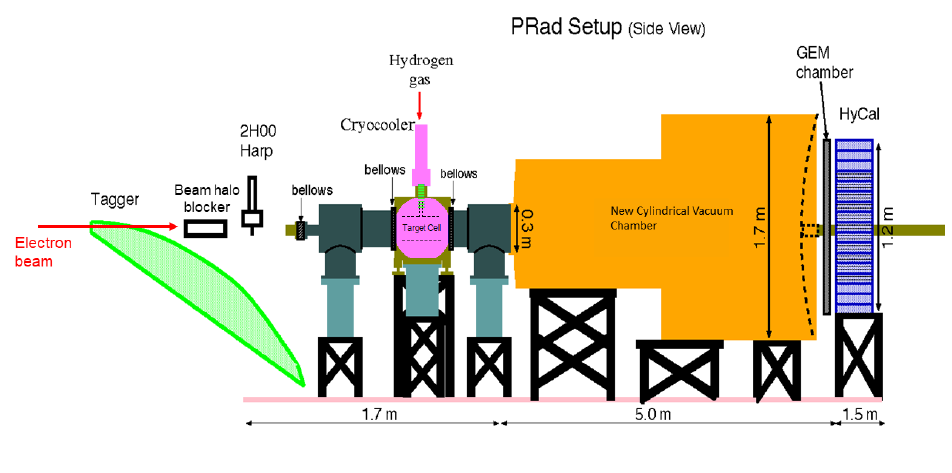
Figure 3. The schematic of the PRad